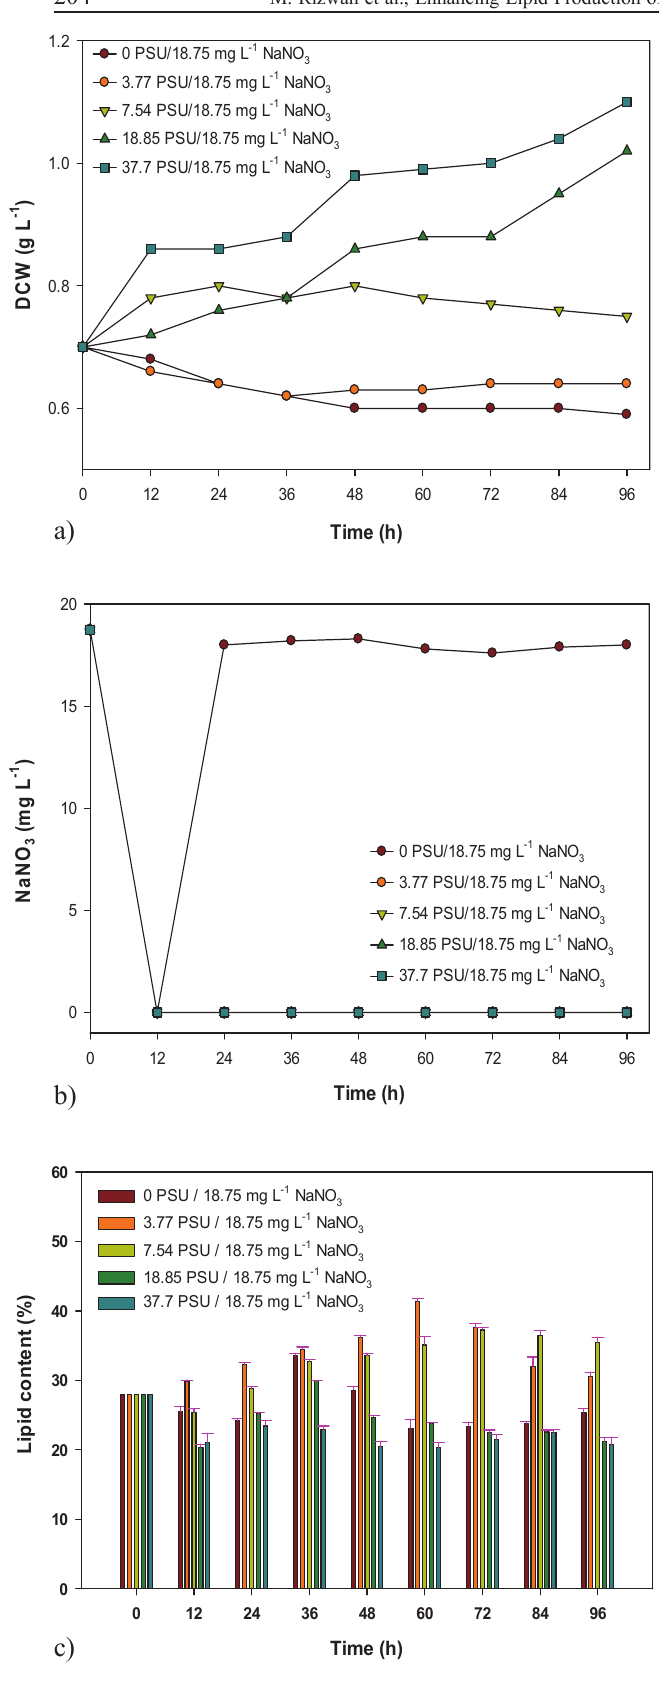
Fig. 4 – Effect of salinity variation and fixed nitrogen (18.75 mg L –1 ) on (a) dry cell weight, (b) nitrogen con- sumption rate, (c) lipid